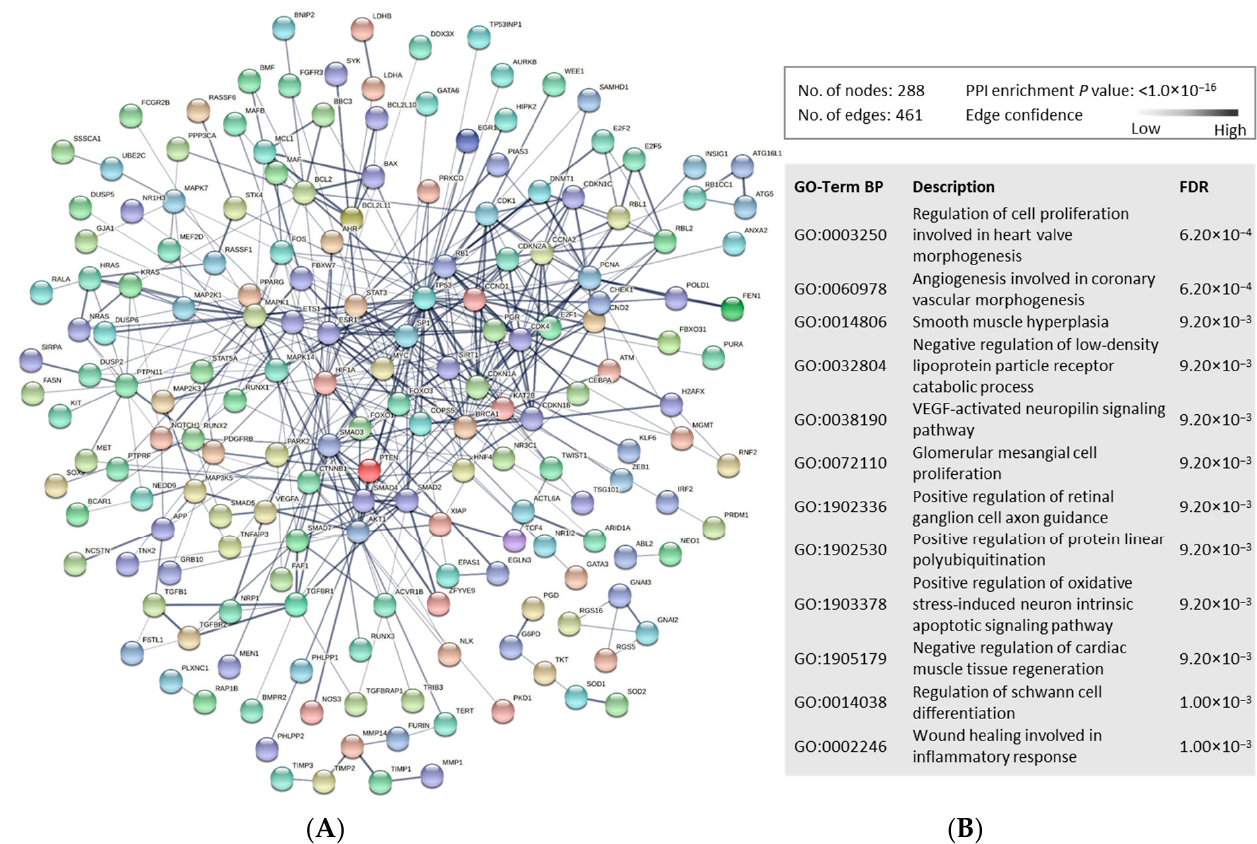
Figure 3. Discriminative performance of the identified miRNA panel to identify AIS patients. Or- thogonal projections to latent structures-discriminant analysis (OPLS-DA) was performed using the top differentially regulated miRNAs ( n = 24) in the discovery cohort data. The classifier was trained on data from all participants in ( A ). discovery cohort ( n = 122) and tested on the ( B ). validation cohort ( n = 119). Scatter plots show the predictive component to discriminate AIS cases from TIA cases (blue dots—x-axis) versus the orthogonal component representing a multivariate confounding effect that is independent of stroke (maroon dots—y-axis). ( C ). ROC curve analysis generated an area under the curve (AUC) of 0.901.